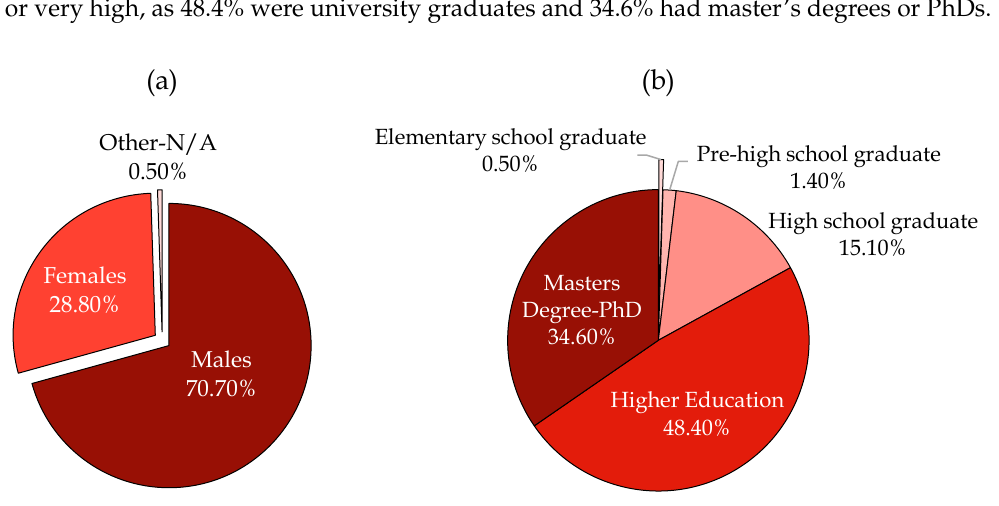
Figure 1. Distribution of the participants by ( a ) gender and ( b ) educational level.